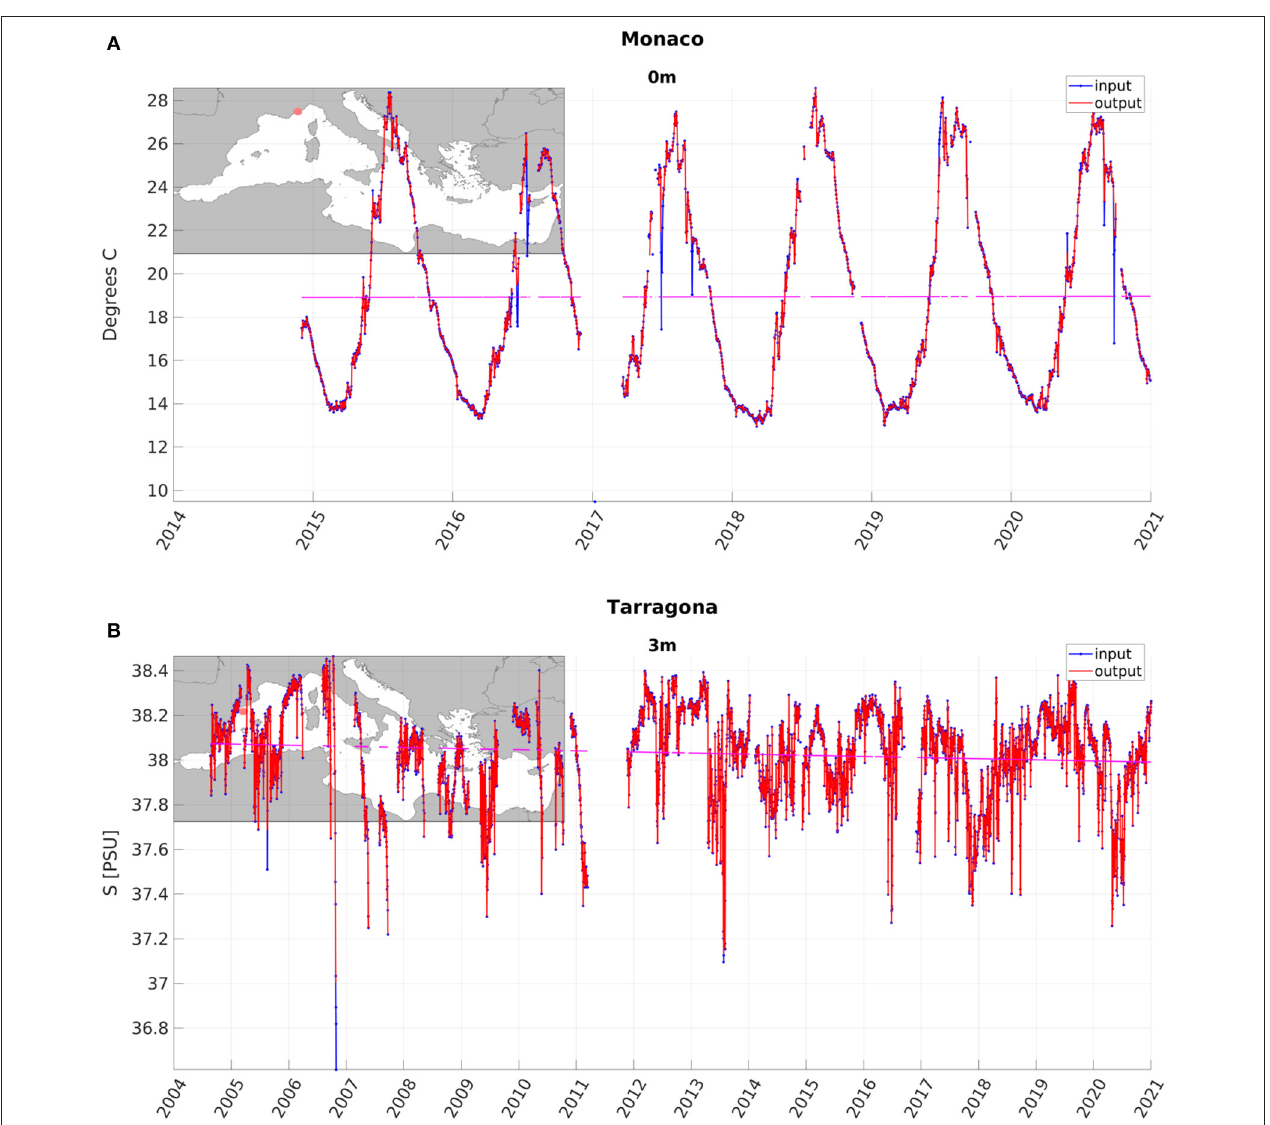
FIGURE 9 | Daily averages computed without (black line) executing and after applying the SOURCE data reprocessing (gross QC and recursive statistical QC): (A) surface temperature at Monaco station; (B) salinity at Tarragona station at 3 m depth.